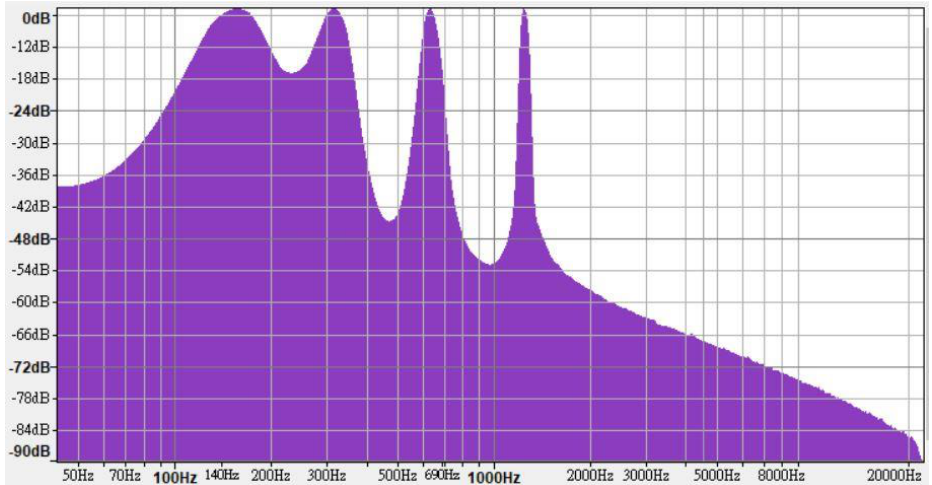
Figure 4. Frequency characteristics of low-frequency warning sound.